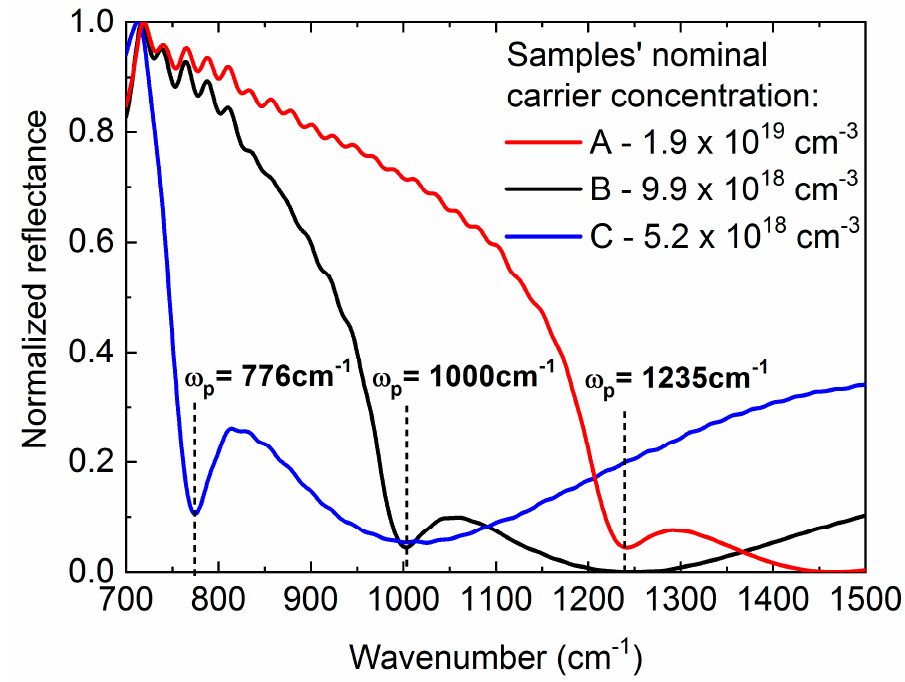
Figure 2. Normalized p-polarized reflectance spectra for Sample A (red curve), Sample B (black curve), and Sample C (blue curve) together with given characteristic reflectance minima at plasma frequencies and indication of carrier nominal concentration.